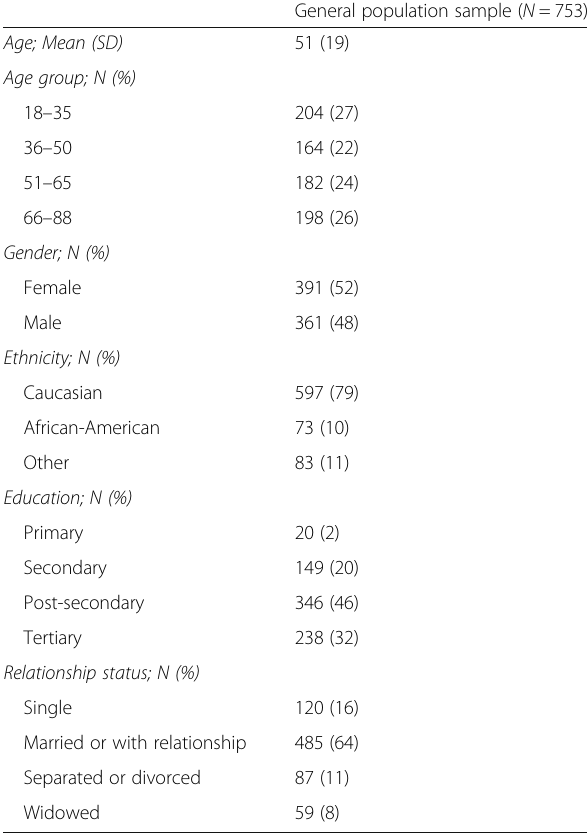
Table 1 Demographic Characteristics of the PROMIS